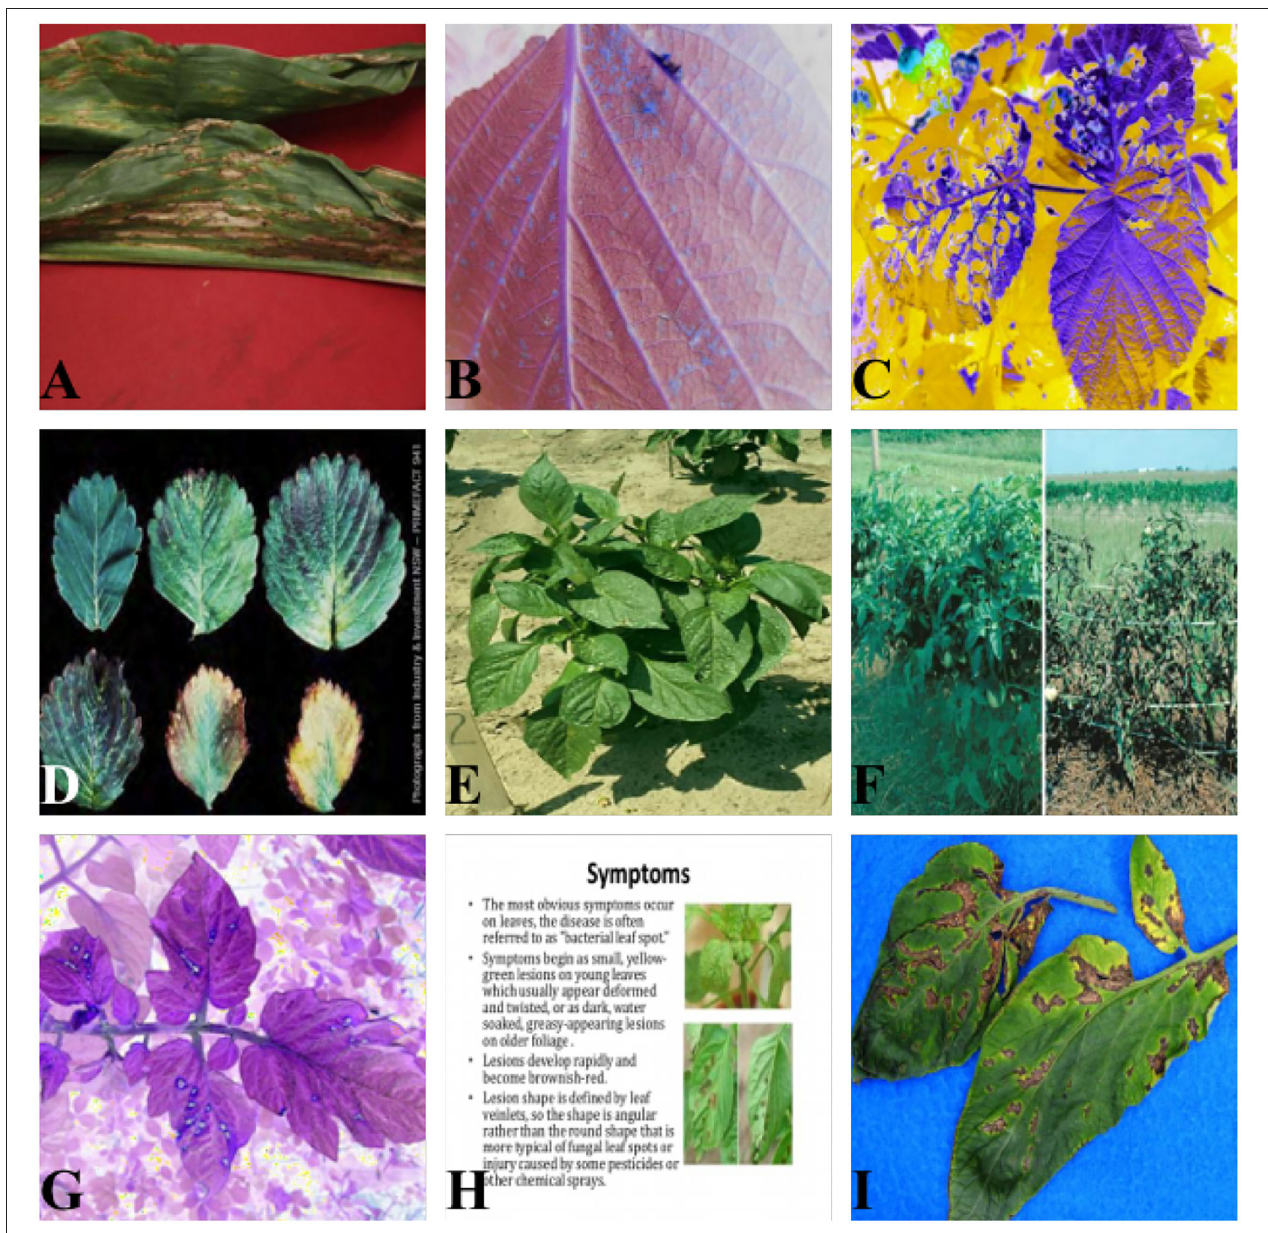
FIGURE 1 | Dataset visualization. (A,D,I) Images on solid color backgrounds. (B,C,G) Images via color channel variation. (E,F) Images from practical production scenes. (H) Electronic document